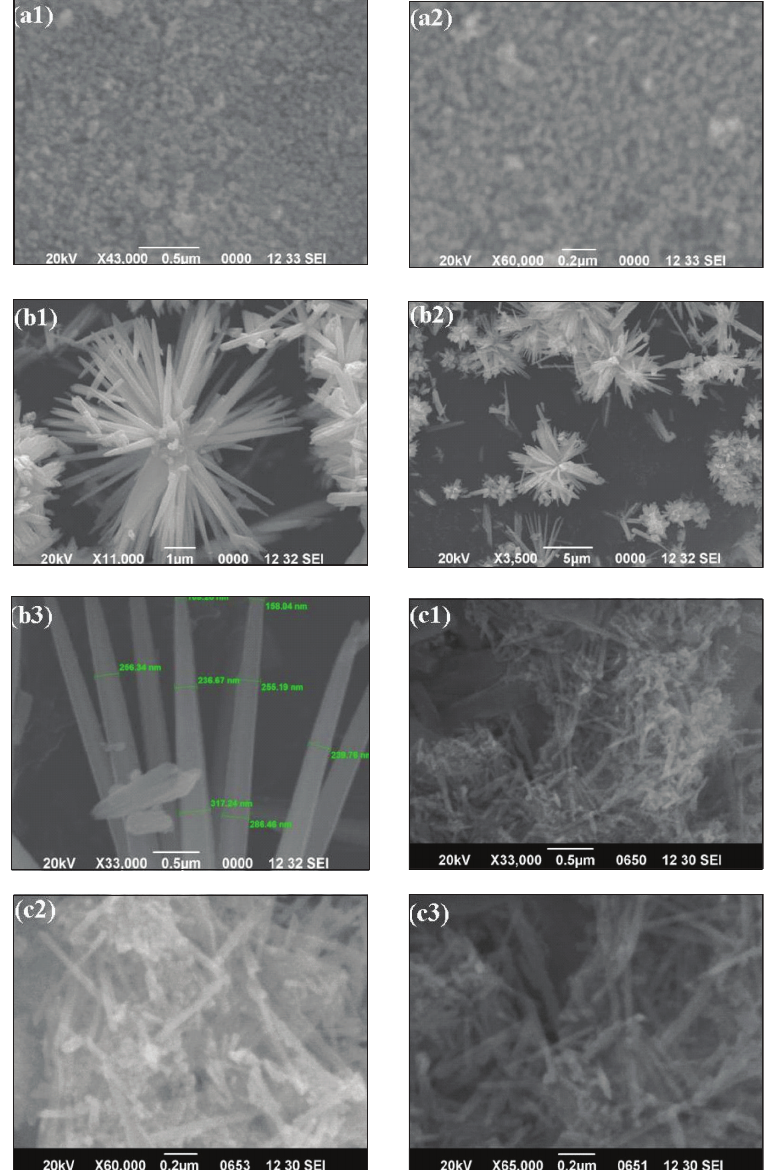
Figure 6: (a1-a2) Typical SEM images of ZnO nanoparticles, (b1–b3) nanoflowers under di ff erent magnifications, and (c1–c3) short- and long-sized hexagonal shaped ZnO